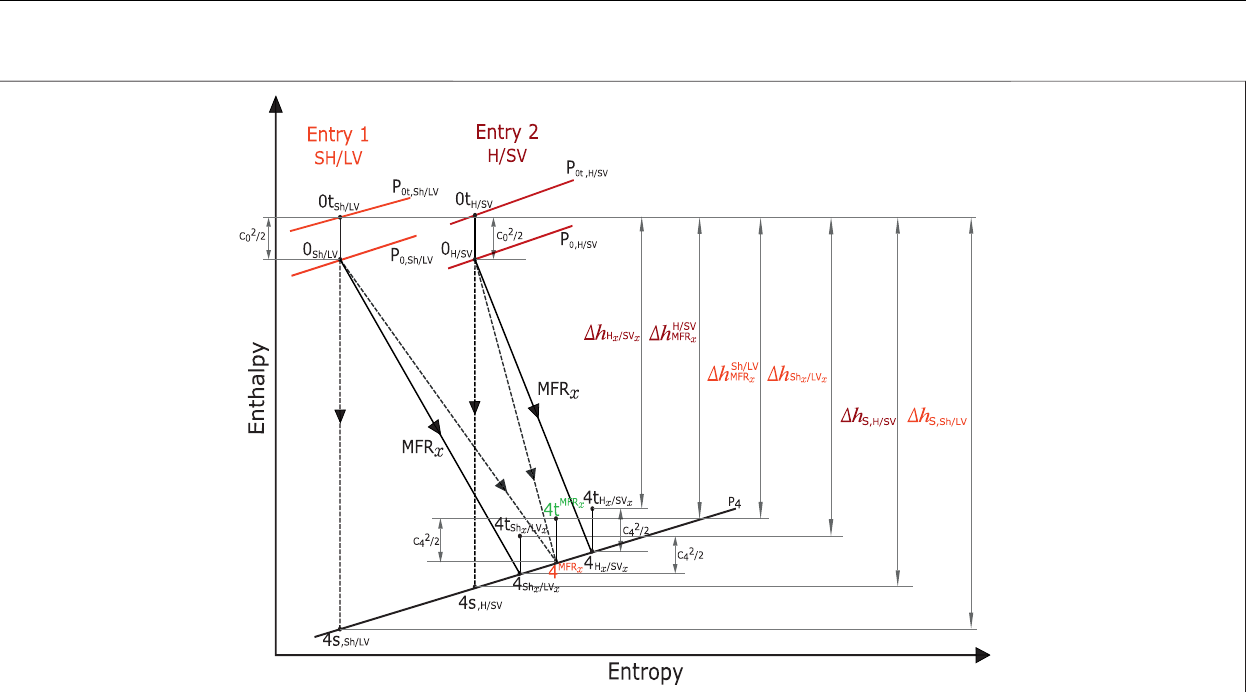
Frontiers in Mechanical Engineering |